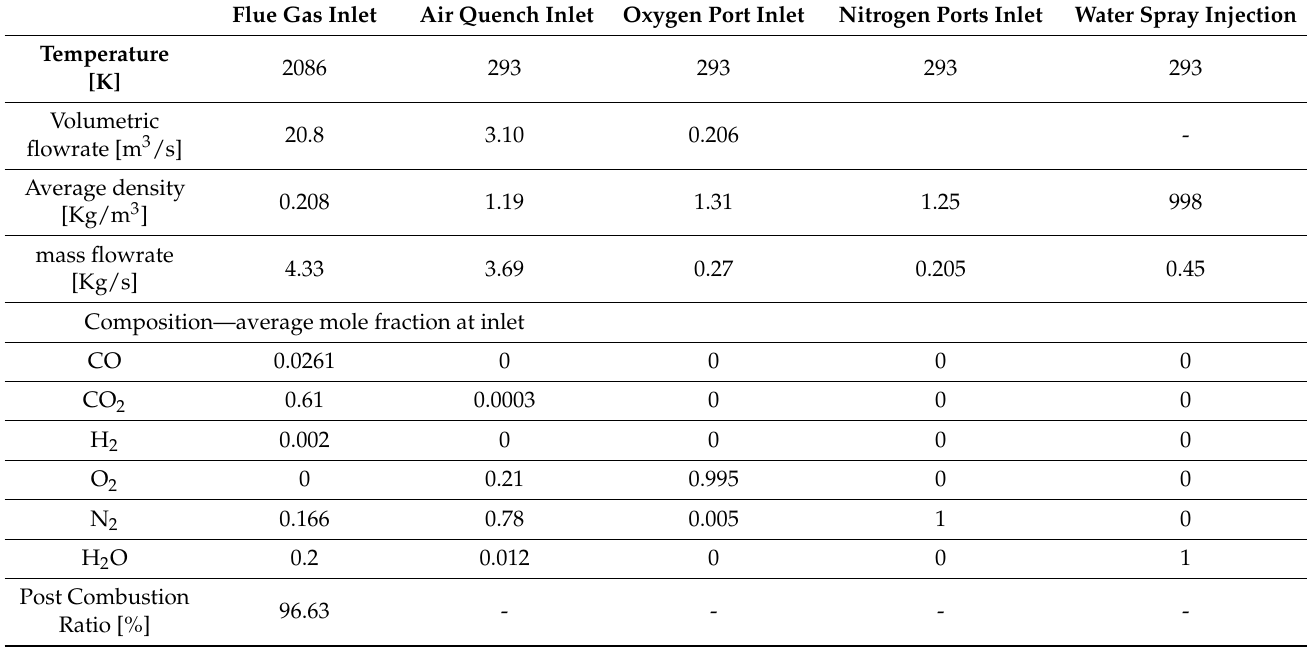
Table 2. Inlet boundary conditions for CFD model